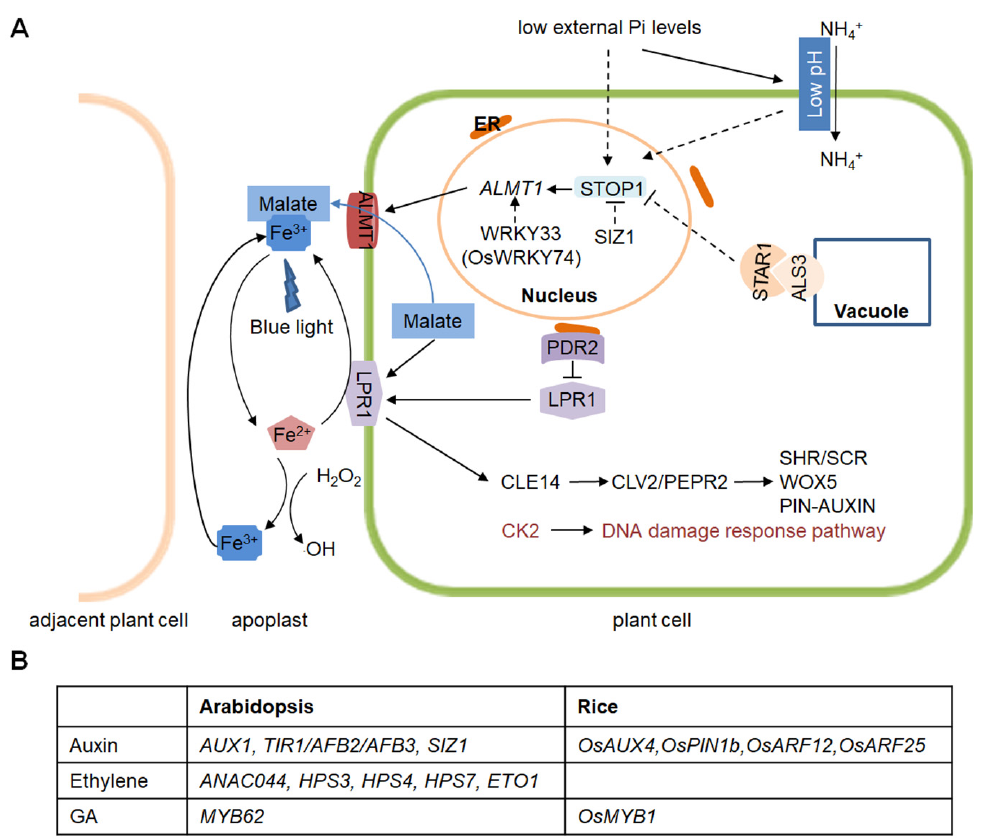
Figure 1. A working model of the molecular mechanisms by which Pi starvation inhibits PR growth in Arabidopsis and rice. ( A ) The working model for Pi-dependent PR growth (rice homologous genes are labeled). The model is modified from that of Liu et al. (2021), with updated genes in Arabidopsis and rice. Arrows with solid lines indicate a promotion, dashed arrows represent unconfirmed events, and blunt arrows represent negative regulation. ( B ) Hormone signaling pathway genes known to be involved in the Pi deficiency-mediated regulation of PR growth in Arabidopsis and